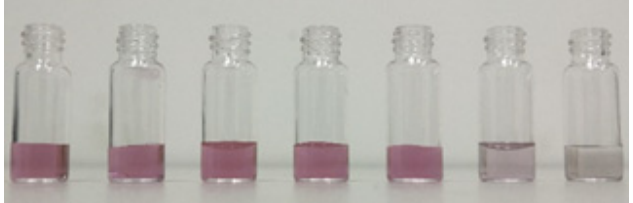
Figure 5. Color change of Aspergillus flavus spore suspension mixed with nano gold sol.